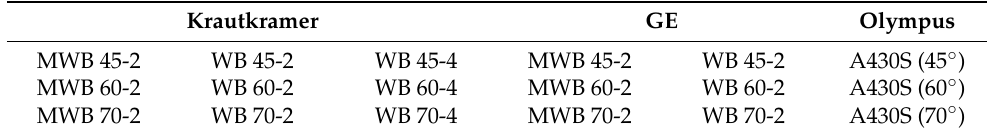
Table 1. Probes used in acquisition of the